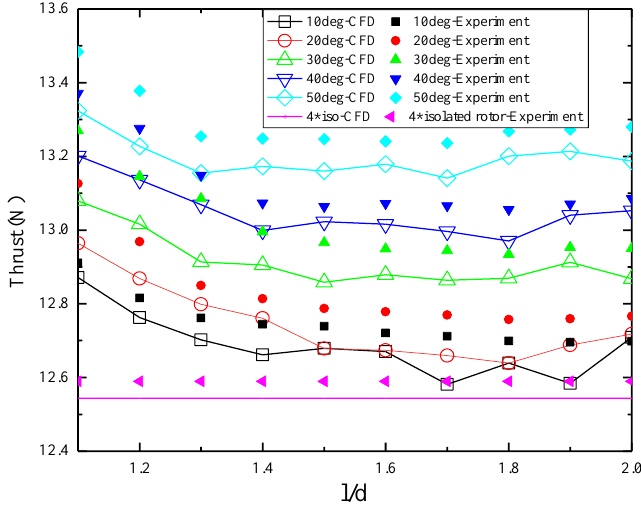
Figure 17. Thrust variation of non-planar quadrotor.